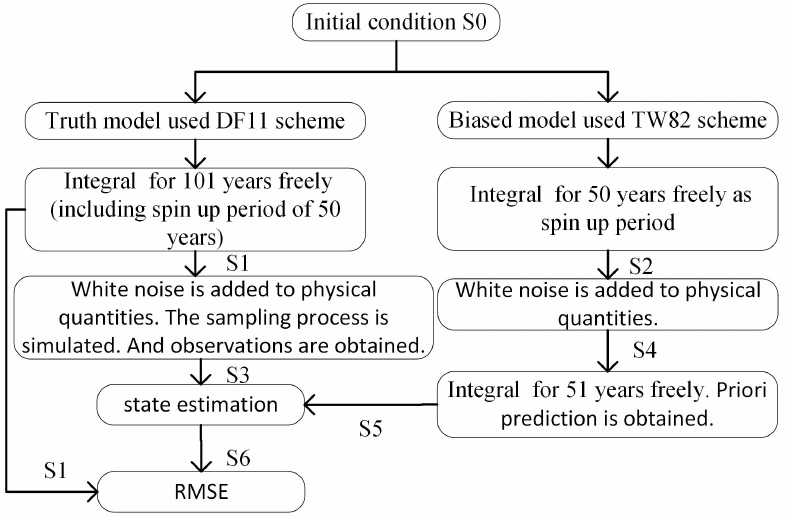
Figure 1. The flow chart of the twin experiment framework’s setup with